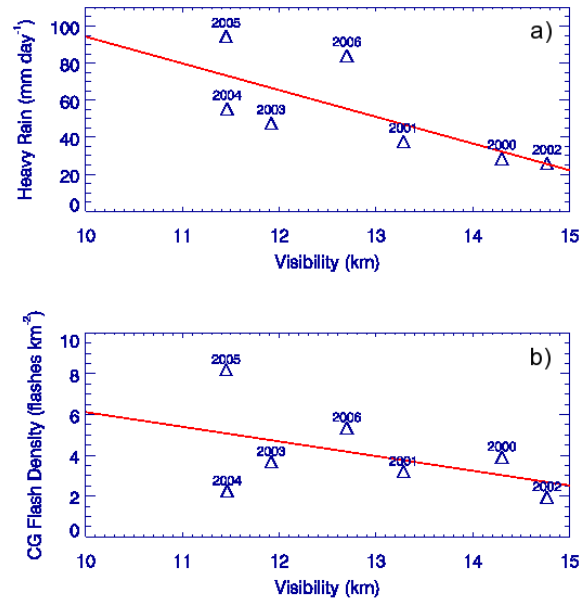
Figure 2. Fig. 2. (a) Correlation between daily visibility and the heavy rain- fall rate over PRD from 2000 to 2006. Both daily visibility and heavy rainfall rate are averaged over the four-month period (from March to June). The heavy rainfall rate is calculated from each rain gauge station with a daily rainfall greater than 25mm. The line represents a linear regression through all data. (b) Correlation Fig. 1. (a) Annual mean AOD from the MODIS satellite in 2005 between daily averaged visibility and accumulated lightning flash Figure 1. over southern China. (b) Annual mean CG flash density distribution density (flasheskm − 2 ) during the four months from 2000 to 2006. in 2005 from the local lightning detection network in the Guang- The line represents a linear regression through all dong Province.